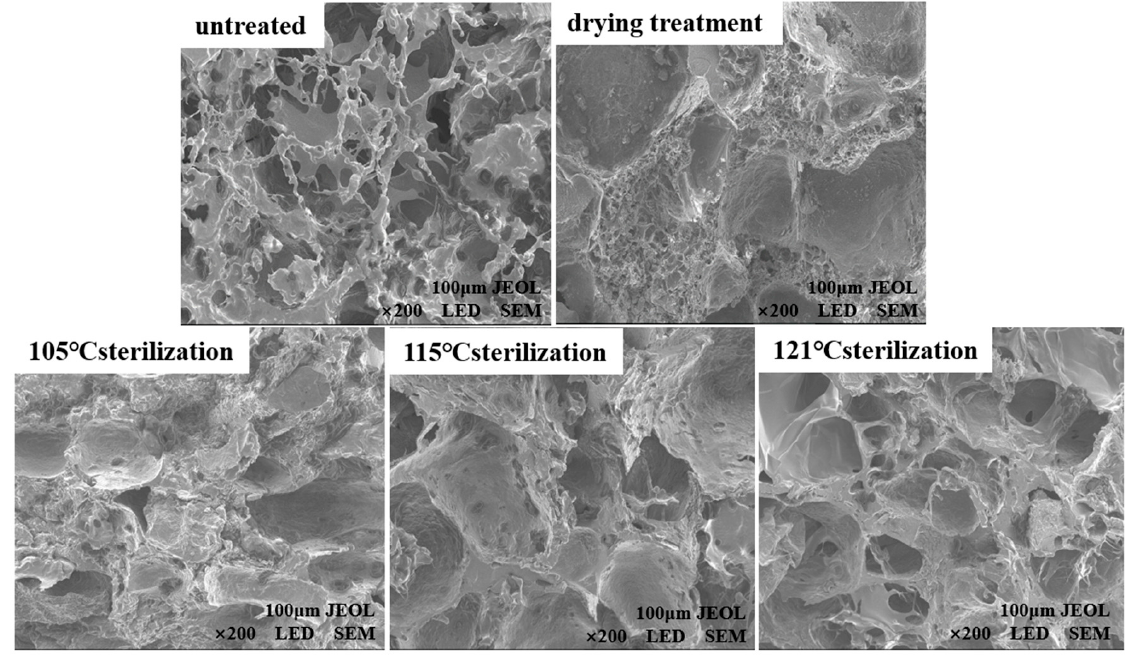
Figure 2. Comparison of microstructure of tilapia fish cake under different treatments methods.